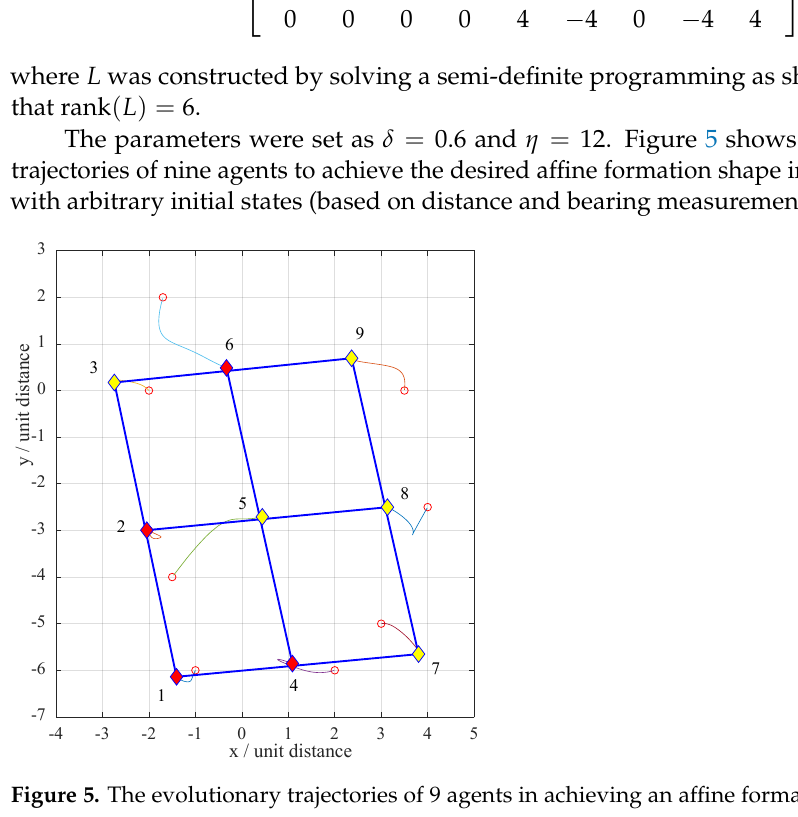
Figure 5. The evolutionary trajectories of 9 agents in achieving an affine formation in R 2 . The red diamonds represent the agents with bearing measurements while the yellow ones represent the agents with distance measurements.The red circles indicate the initial states of the agents and the blue lines construct the affine formation